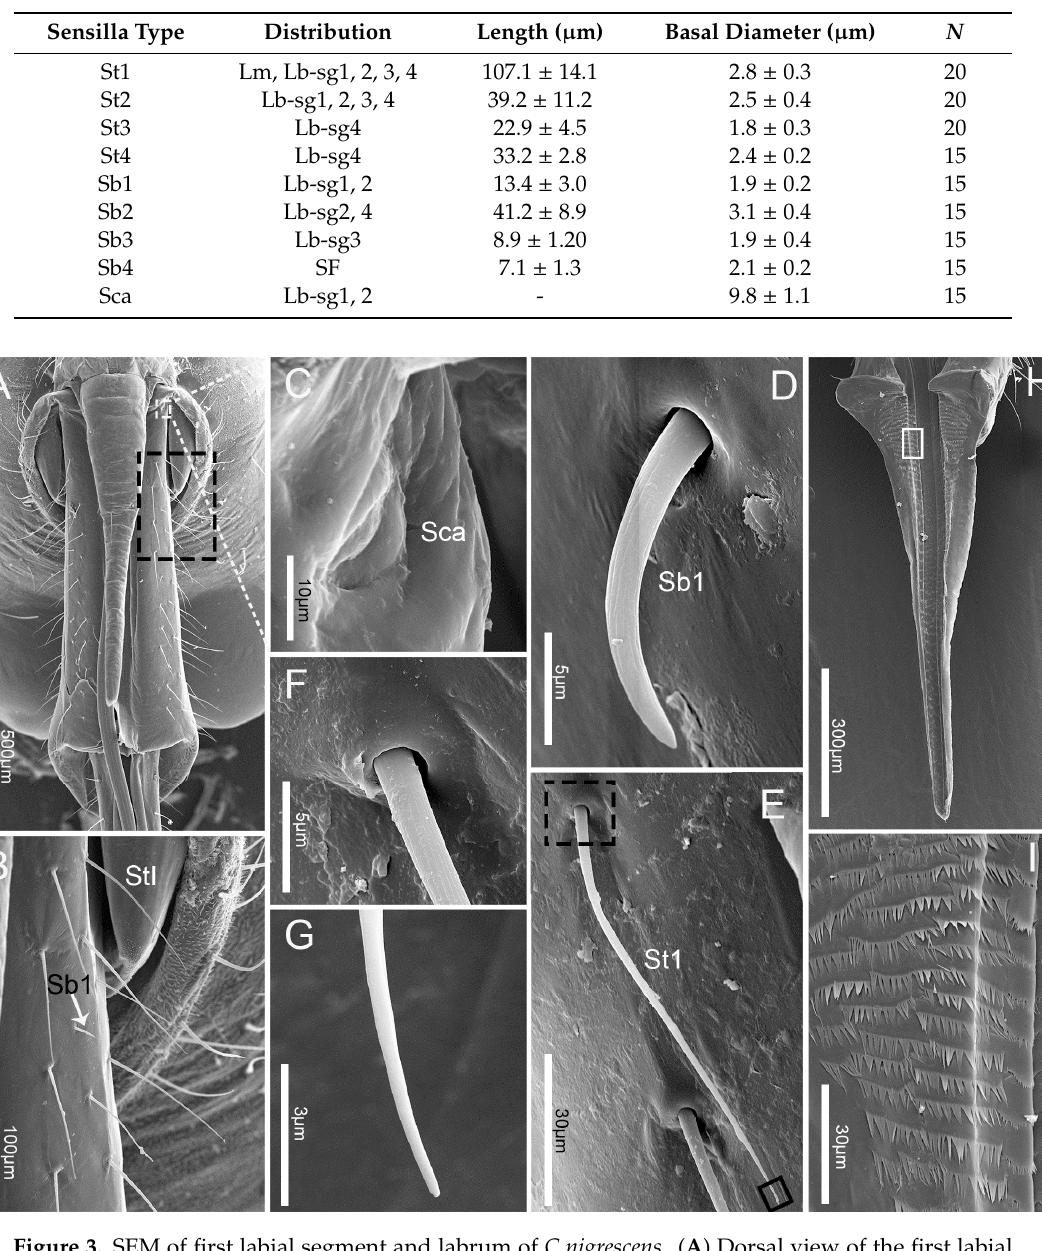
Table 2. Morphometric data (mean ± SE) for various sensilla of adult C. nigrescens. N = sample size. Lb-sg1, 2, 3, 4, the first, second, third, and fourth segment of labium; Lm, labrum; Sb1–4, sensilla basiconica I–IV; Sca, sensilla campaniformia; SF, sensory field on the labial tip; and St1–4, sensilla trichodea I–IV.